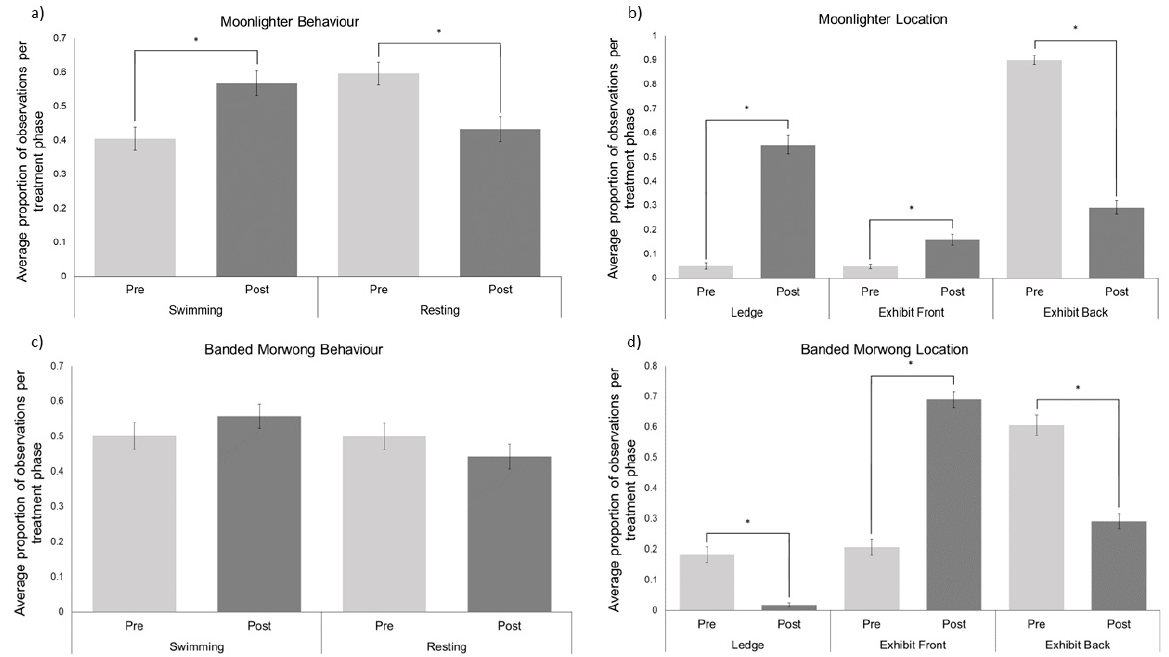
Figure 3. ( a ) The average proportion of time the moonlighter ( n = 1) spent performing natural behaviours pre ‐ post reno ‐ vations. ( b ) The average proportion of time the moonlighter ( n = 1) spent in each exhibit location pre ‐ post renovations. ( c ) The average proportion of time the banded morwong ( n = 1) spent performing natural behaviours pre ‐ post renovations. ( d ) The average proportion of time the banded morwong ( n = 1) spent in each exhibit location pre ‐ post renovations. Pre ‐ renovations means are represented by light grey bars and post ‐ renovations are represented by dark grey bars for all pan ‐ els. The error bars represent the SEM and the * indicate statistically significant differences ( p < 0.05).